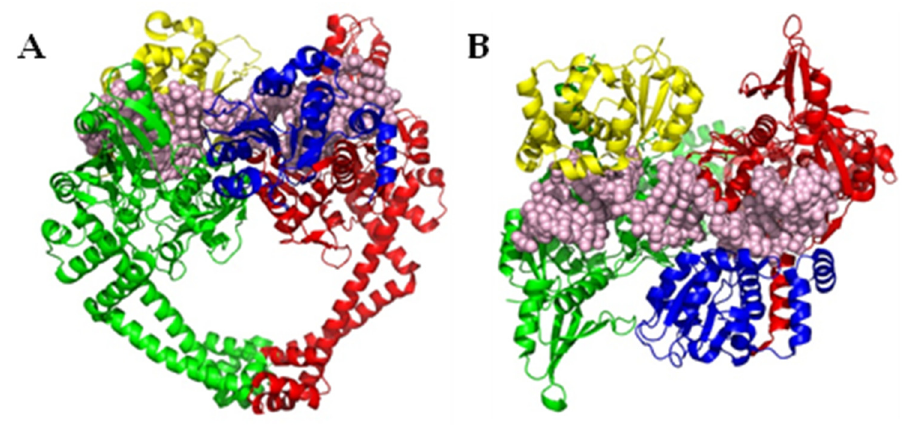
Figure 1. ( A ) Front view of Staphylococcus aureus DNA gyrase (PDB ID 6QX2 [13]), representative of the structure of type II topoisomerases. ( B ) Top view of S. aureus DNA gyrase, rotated 90° forwards from ( A ). The GyrA/ParC units of topoisomerase (green and red cartoons) are known to be critical to the actions of DNA strand breakage and covalent linkage of the phosphate backbone (whole DNA segment in pink spheres) to a conserved tyrosine residue in the active site, whilst the GyrB/ParE units (yellow and blue cartoons) are required for interactions with ATP. Both of these interactions are putative targets for topoisomerase inhibitors.